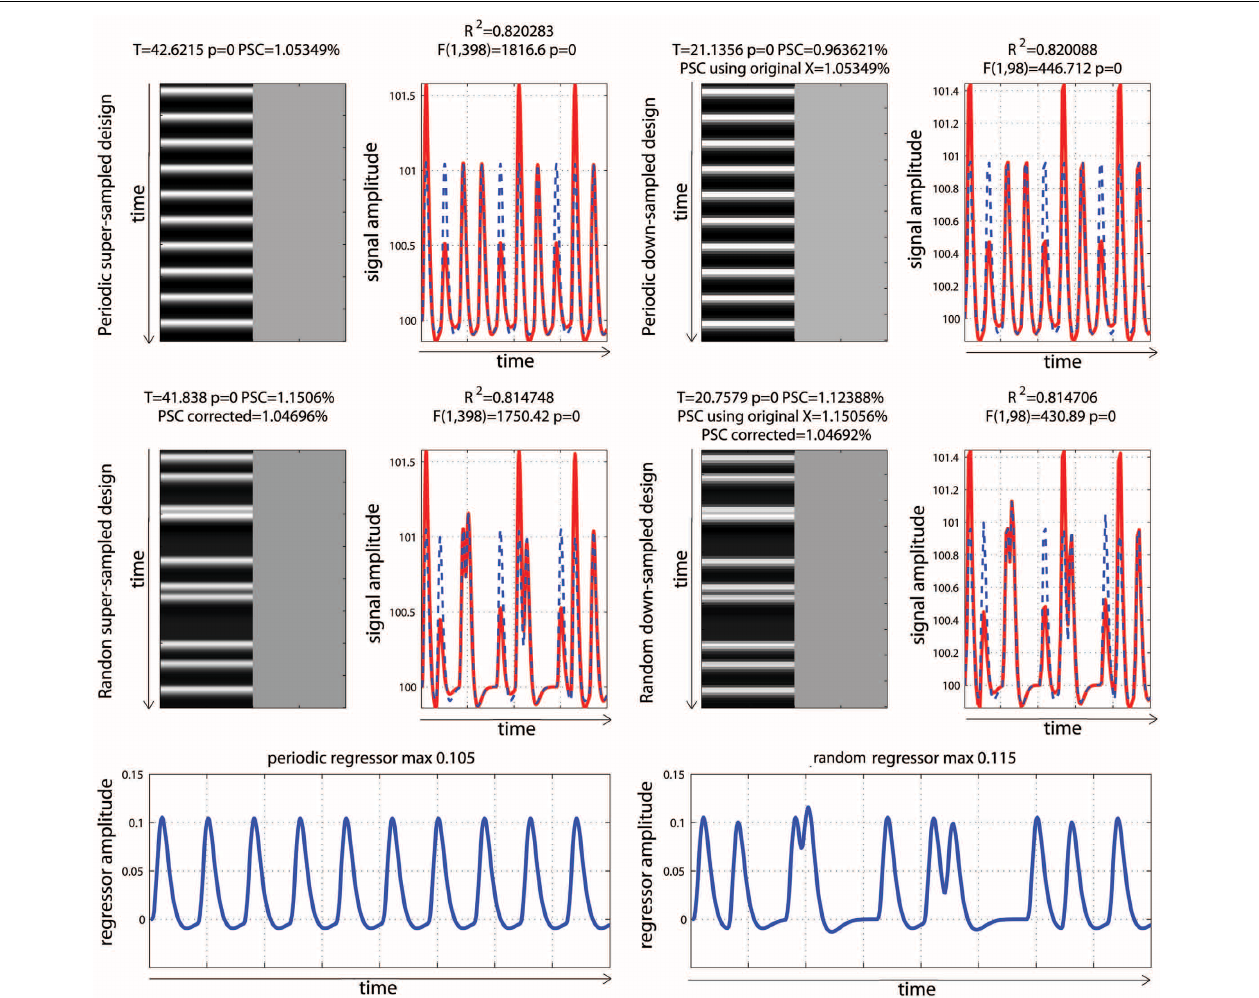
FIGURE 6 | Periodic vs. random event related designs with a single “active” condition. On the left are displayed the original design matrices and data and on the right their down-sampled version. PSC stands for Percentage Signal Change computed using the parameters from the hrf and a scaling factor taken as the maximum of the design matrix. PSC using original X (for down sampled data only),